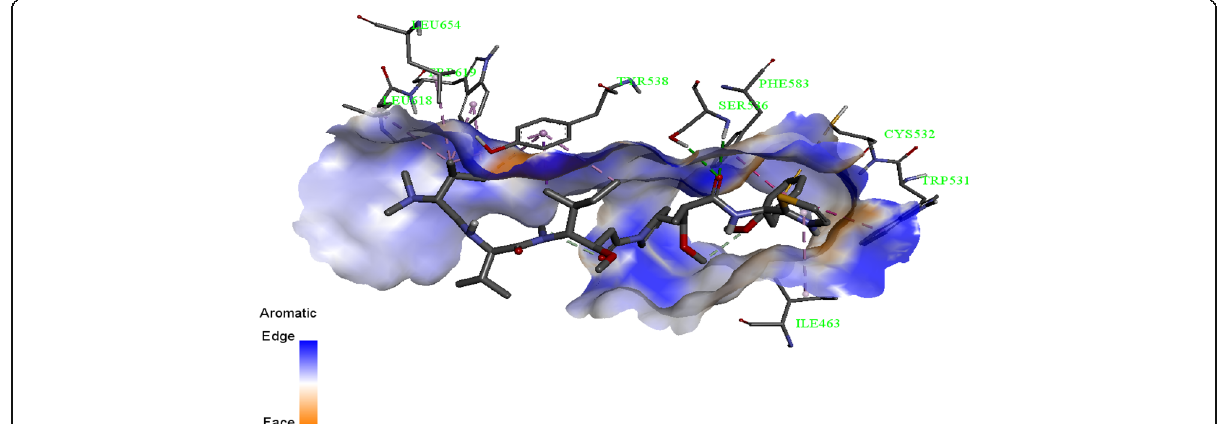
Fig. 8 3D diagram of the interaction between N4 with V600E-BRAF